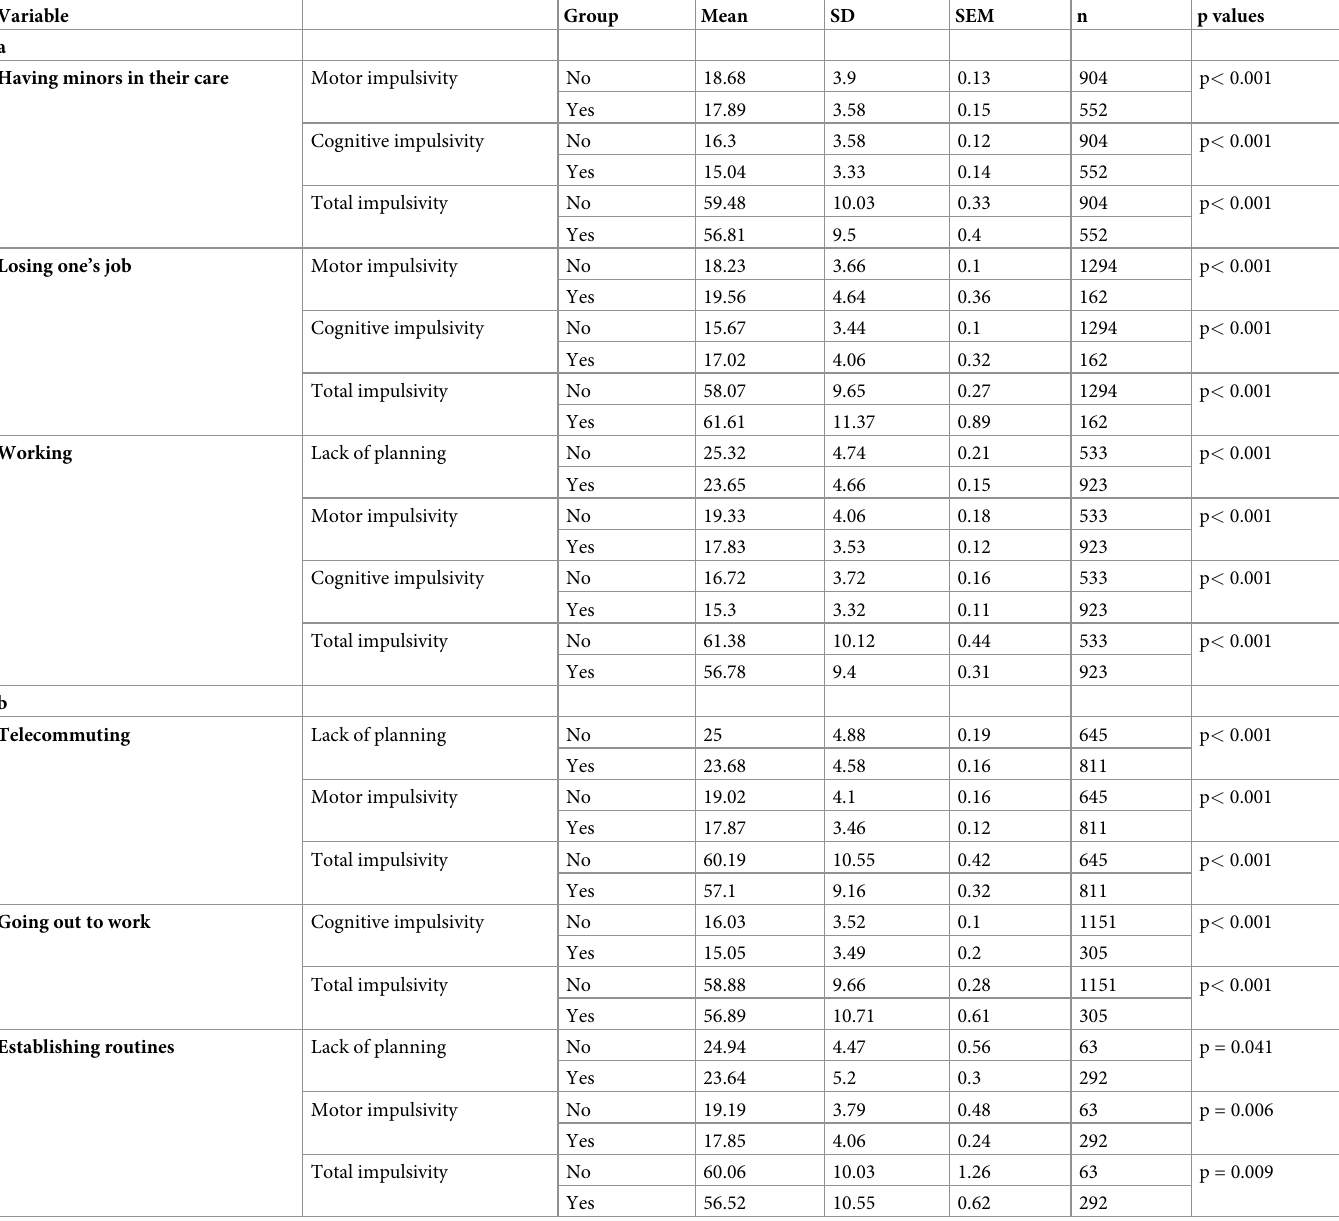
Table 4. (a) COVID lockdown variables that were significantly related to impulsivity. (b) COVID lockdown variables that were significantly related to impulsivity.